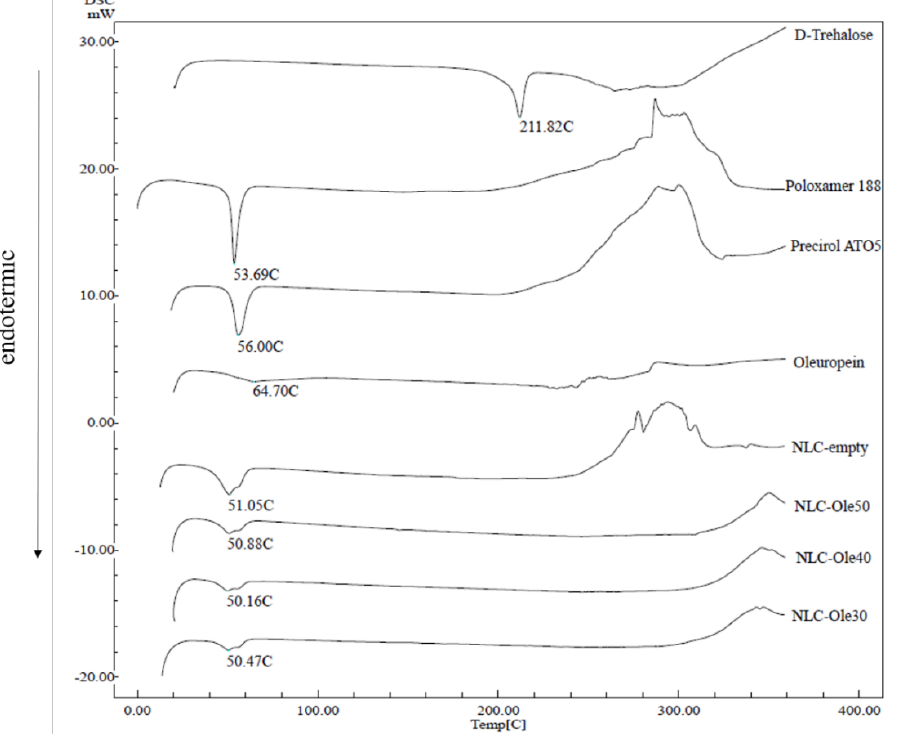
Figure 1. Physico-chemical characterization of OLE-loaded nanoparticles after freeze-drying. (a) Particle size, PDI, Z potential, encapsulation efficiency, total released oleuropein and moisture content of nanoparticles. (b) TEM micrographs of oleuropein loaded (NLC-OLE30, NLC-OLE40, NLC-OLE50) and empty nanoparticles (NLC-empty). (c) In vitro release of oleuropein from developed NLCs.